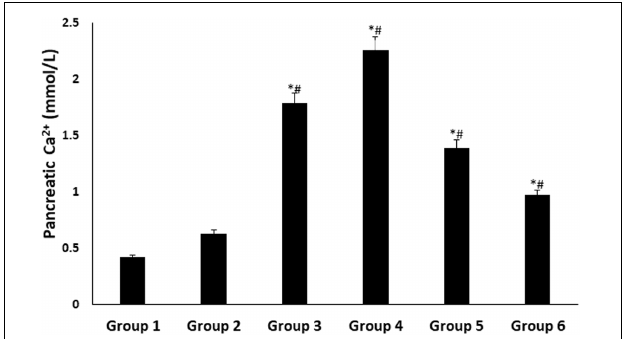
FIGURE 5 | Pancreatic Ca 2 + level of experimental groups. Data = mean ± SD ; n = 6. ∗ Statistically significant ( p < 0.05) compared to group 2; # statistically significant ( p < 0.05) compared to group 1. Group 1: normal control; Group 2: diabetic control; Group 3: diabetic rats + crude extract; Group 4: diabetic rats + dichloromethane fraction; Group 5: diabetic rats + butanol fraction; Group 6: diabetic rats + aqueous fraction.